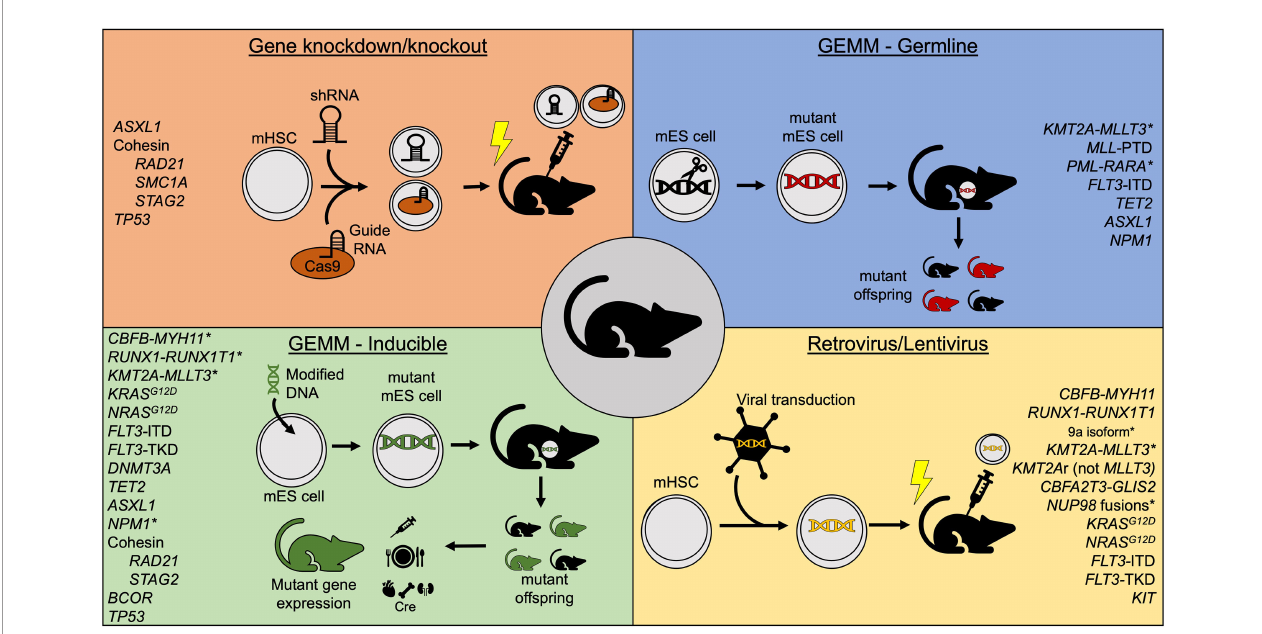
FIGURE 1 | Summary of commonly used mouse model methods to study acute myeloid leukemia. *Indicates models that independently generate leukemia without cooperating mutations. GEMM, Genetically-engineered mouse model; mHSC, murine hematopoietic stem cell; mES, murine embryonic stem cell; shRNA, short hairpin